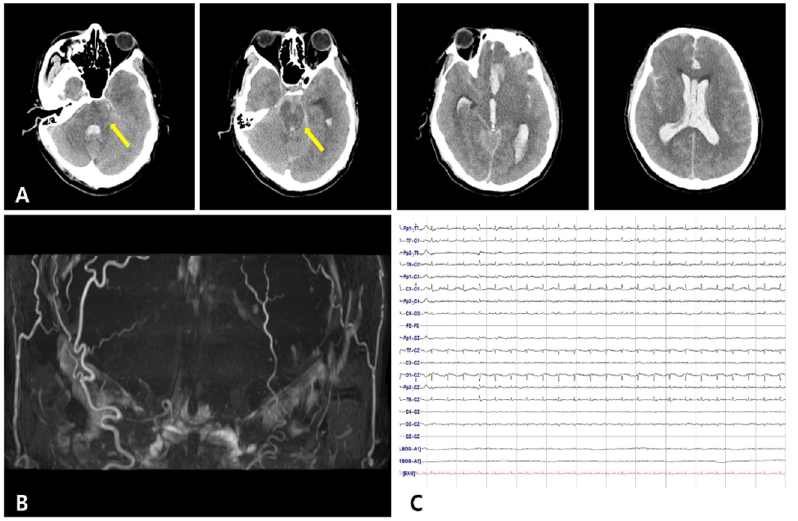
Figure 1. Radiologic findings and electroencephalography of the patient. ( A ) Brain computed tomography shows intracerebral hemorrhage in the left frontal lobe and massive intraventricular hemorrhage with subarachnoid hemorrhage including the basal cistern. Hypodense lesions in the brain stem were observed due to hypoxic brain damage (arrow). ( B ) Brain magnetic resonance angiography of the patient shows no cerebral blood flow. ( C ) There is no identifiable cerebral activity in any lead throughout the recording, even at 2 µV/mm sensitivity.